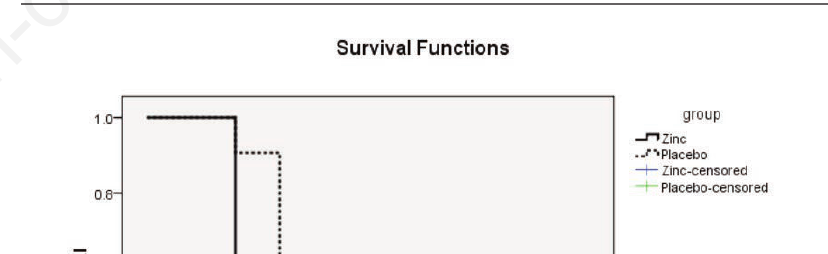
Figure 1. Study flowchart and enrolment.